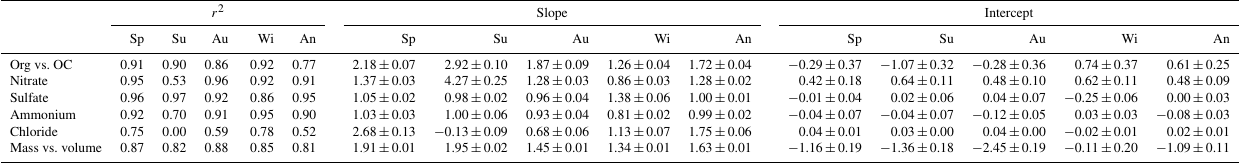
Table 1. Consistency of ACSM measurements: comparison between ACSM and independent analytical techniques using orthogonal regres- sion analyses. Slopes and intercepts are indicated ± uncertainties. r 2 Slope